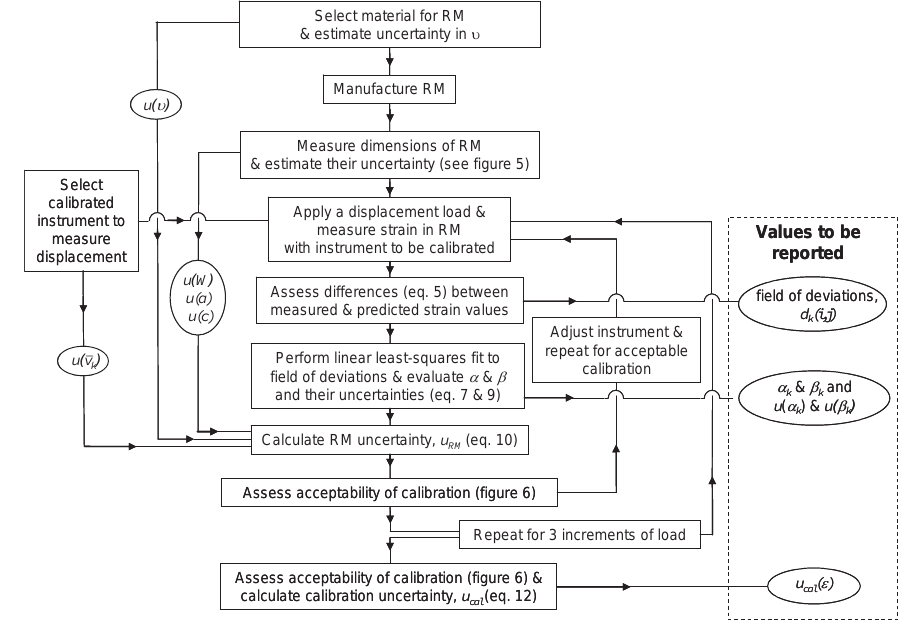
Fig. 4 Flow-chart for performing a calibration of an optical system for full-field strain measurement using the SPOTS reference material where u is uncertainty, W , a and c are characteristic dimensions, (cid:2) is Poisson ratio and (cid:3) and (cid:4) are fit parameters relating to the correlation of the experimental and analytical strain distribution for the gauge section of the beam; the equations and figures referred to can be found in the SPOTS